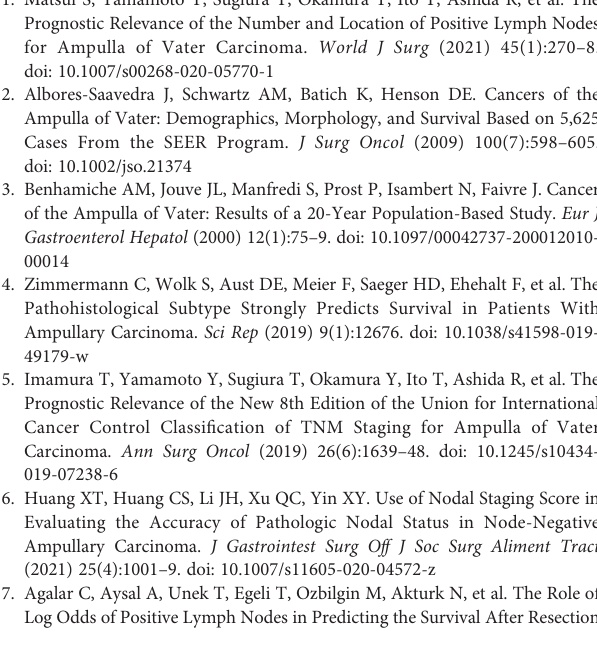
Supplementary Figure 1 | The optimal cut-off value of LNR according to the X- tile software. Supplementary Figure 2 | The optimal cut-off value of total number of lymph nodes examined according to the X-tile software. Supplementary Figure 3 | The proportions of patients in the training cohort and validation cohort under the new staging